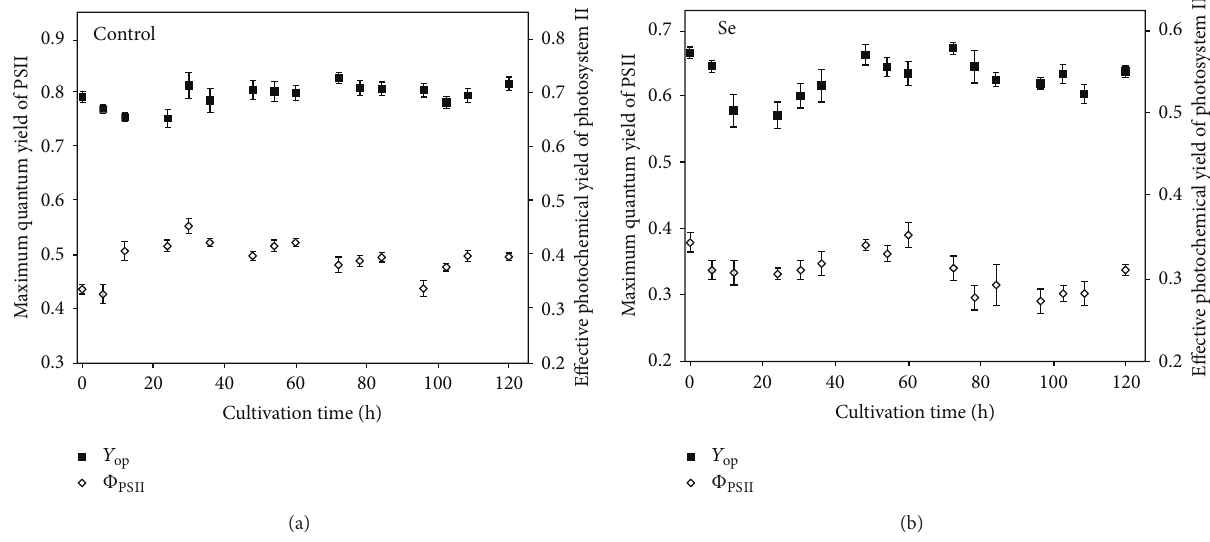
) and effective photochemical yield of PSII (Φ op